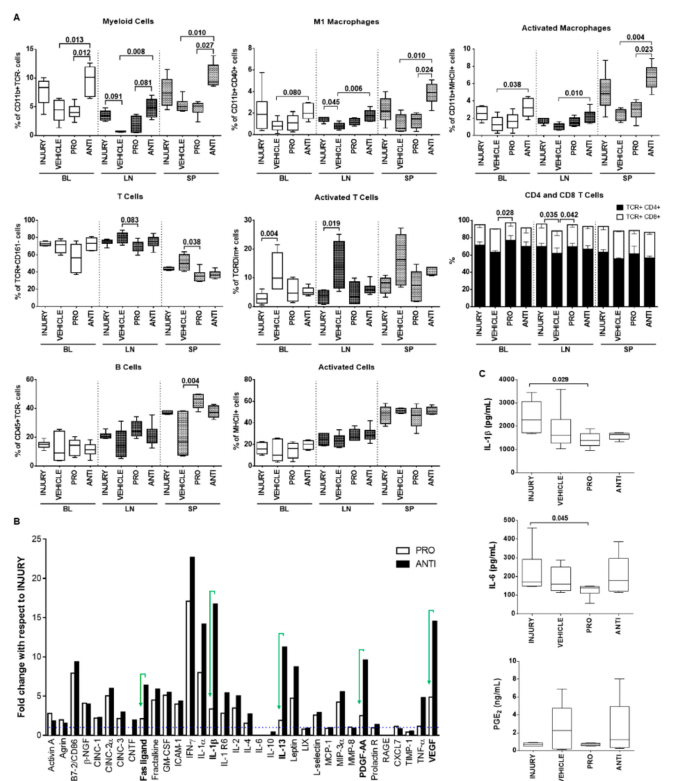
Figure 5. Systemic immune response of animals with degenerated / herniated IVDs injected with pro- and anti-inflammatory treatments 2 weeks postinjury. ( A ) Phenotypic analysis of immune cell populations in peripheral organs: blood (BL), draining lymph nodes (LN) and spleen (SP), using flow cytometry. ( B ) Semiquantitative antibody detection of an array of inflammatory mediators in the rat plasma for INJURY, PRO and ANTI groups, expressed as fold-change with respect to the INJURY group (dashed line, y = 1). IFN- γ , MIP-3 α and IL-1 β were not detected in the INJURY group; for these, an arbitrary value of 1.5 was considered for calculation of fold-change for the remaining groups. ( C ) Quantification of pro-inflammatory cytokines IL-1 β (pg / mL), IL-6 (pg / mL) and PGE 2 (ng / mL) in animals’ plasma by ELISA. Results are presented in box-and-whisker plots with associated p -value ( n = 4–8 animals / group), except the array results presented in a bar